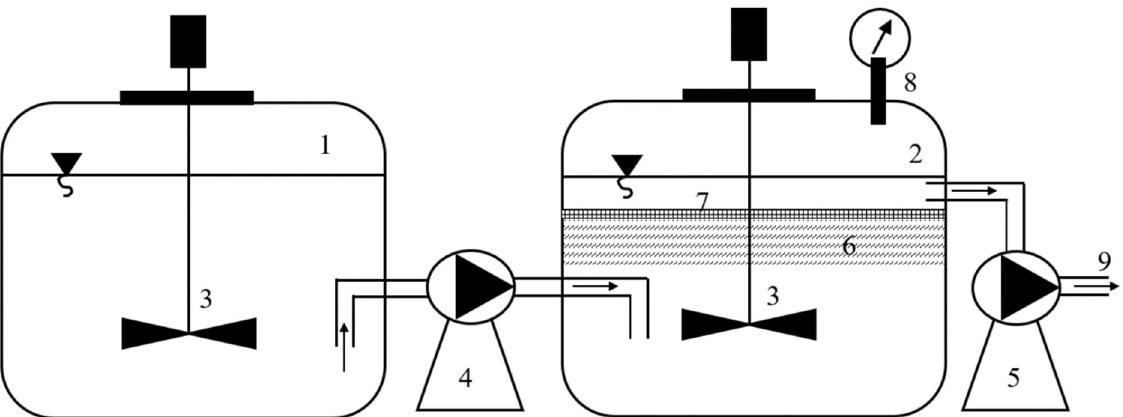
Figure 11. Diagram of the experimental process system: 1—hydrolysis tank, 2—fermentation tank, 3—agitators, 4—rotary lobe pump, 5—peristaltic pump, 6—magneto-active filling, 7—limiting grid, 8—biogas outflow with a meter, 9—outflow of treated effluent.